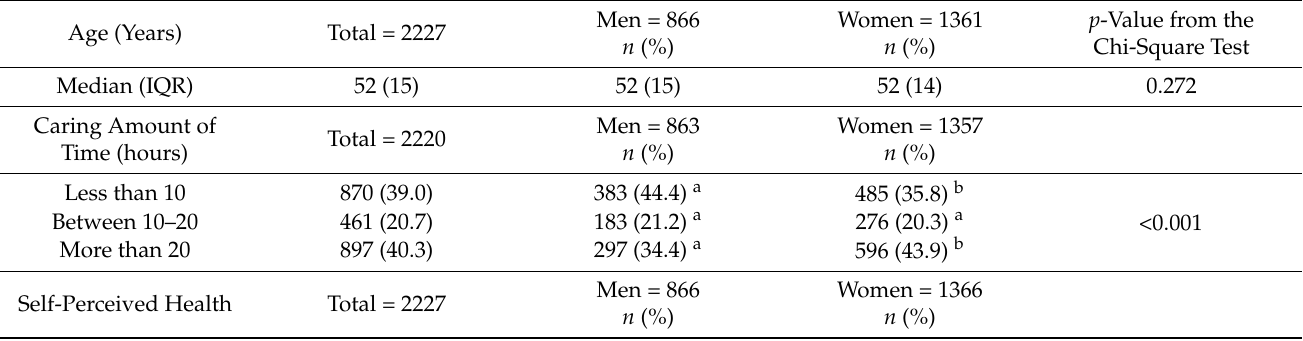
Table 2. Informal age of the caregivers, amount of time caring, self-perceived health, mental health, and their subscales according to the Spanish National Health Survey